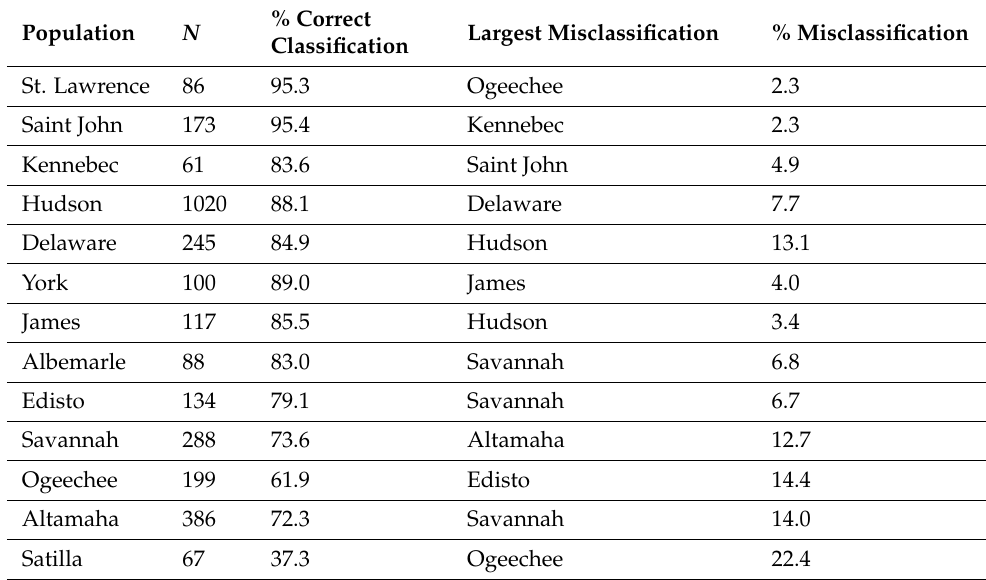
Table 4. Proportion of Atlantic sturgeon baseline reference individuals correctly assigned to the spawning river in which they were collected and the rivers with the largest proportion of misclassifi- cations. These results are based on data from 11 microsatellite loci.